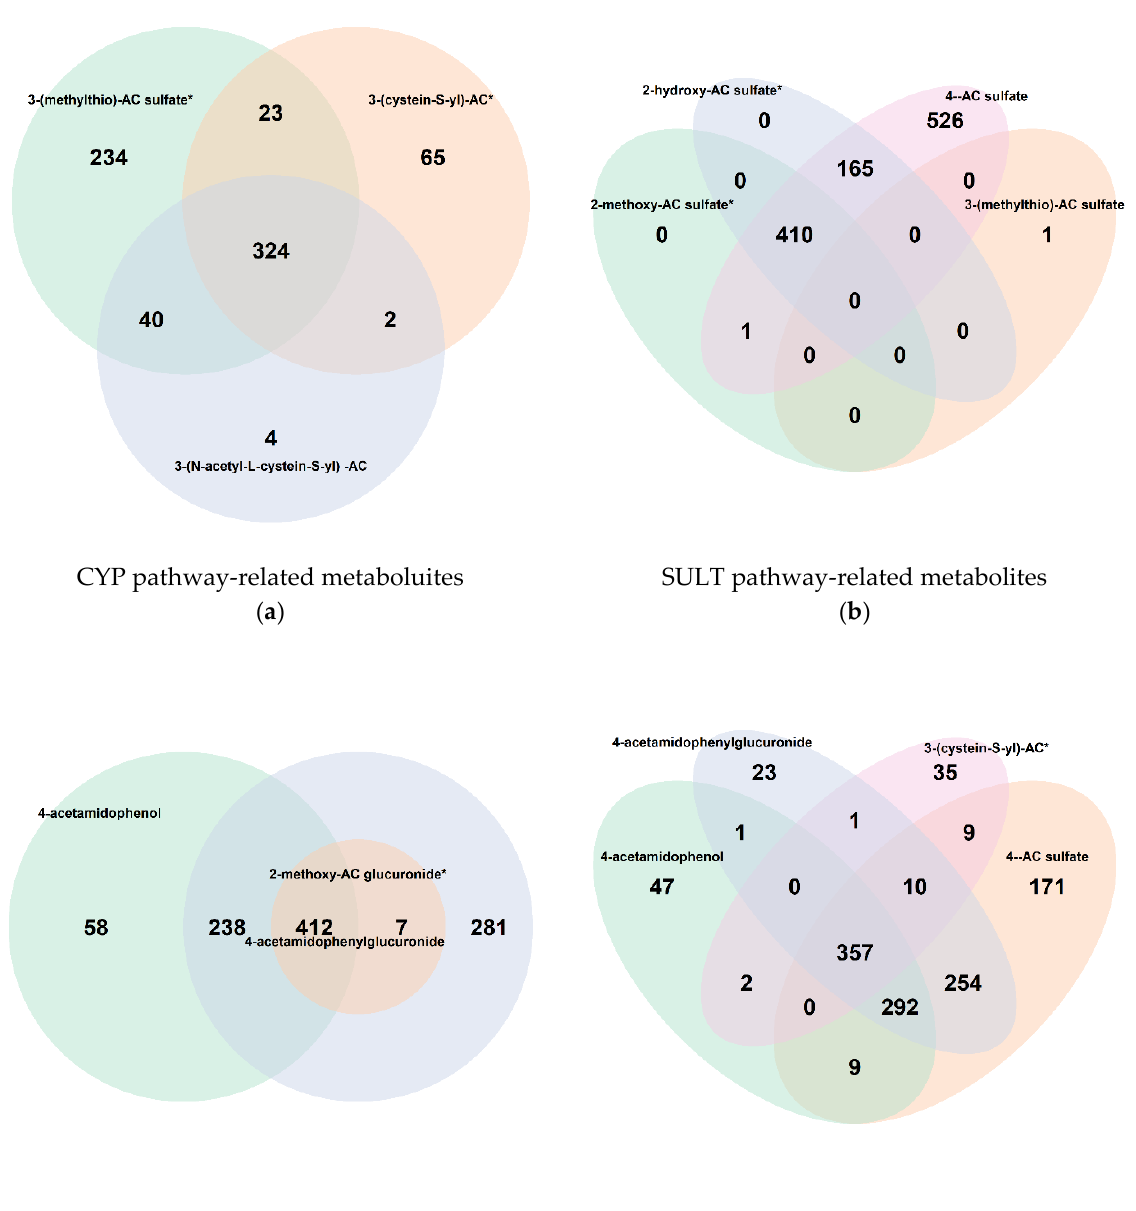
Figure 5. Overlap between acetaminophen metabolites detected in blood. Venn diagrams for the nine acetaminophen (AC) metabolites detected in this study, grouped by metabolites specific to the CYP, SULT, and UGT pathways, resp. ( a – c ), and for the most frequently detected metabolite from each pathway ( d ); all nine AC metabolites were detected together in 310 (11.0%) samples, and at least one AC metabolite was detected in 1255 (44.7%) samples.